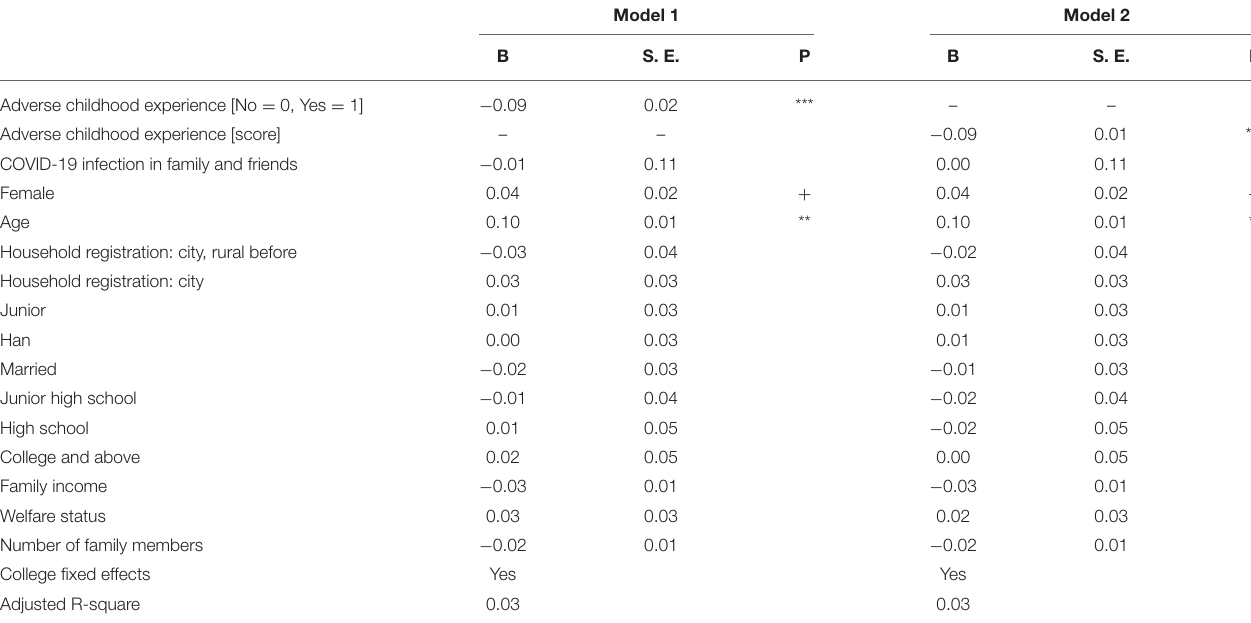
TABLE 3 | Standardized estimates of grit, by OLS regression.